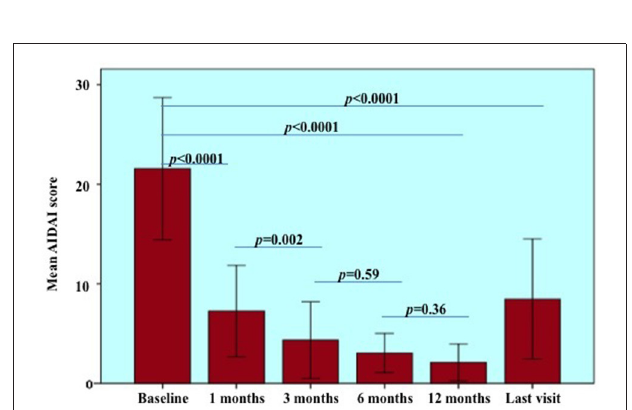
FIGURE 2 | Autoinflammatory disease activity index (AIDAI) recorded at the start of treatment courses (baseline) and during the following visits. Statistical differences resulting from pairwise comparisons between different follow-up visits were provided to better detail the overall significance ( p < 0.0001). Of note, statistical analysis on AIDAI changes was restricted to 18 patients (22 treatment courses) starting treatments after 2014, year of the AIDAI publication. Error bars refer to one standard